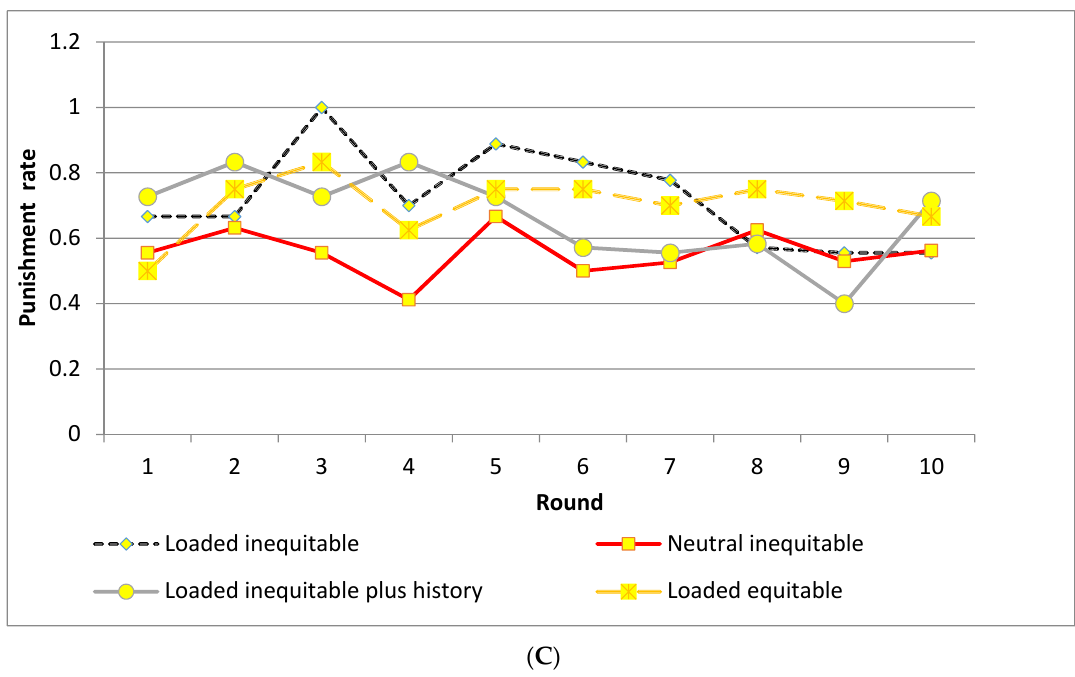
Figure 3. ( A ) Evolution of the bribe rate over ten rounds; ( B ) Evolution of the acceptance rate over ten rounds; ( C ) Evolution of the punishment rate over ten rounds.